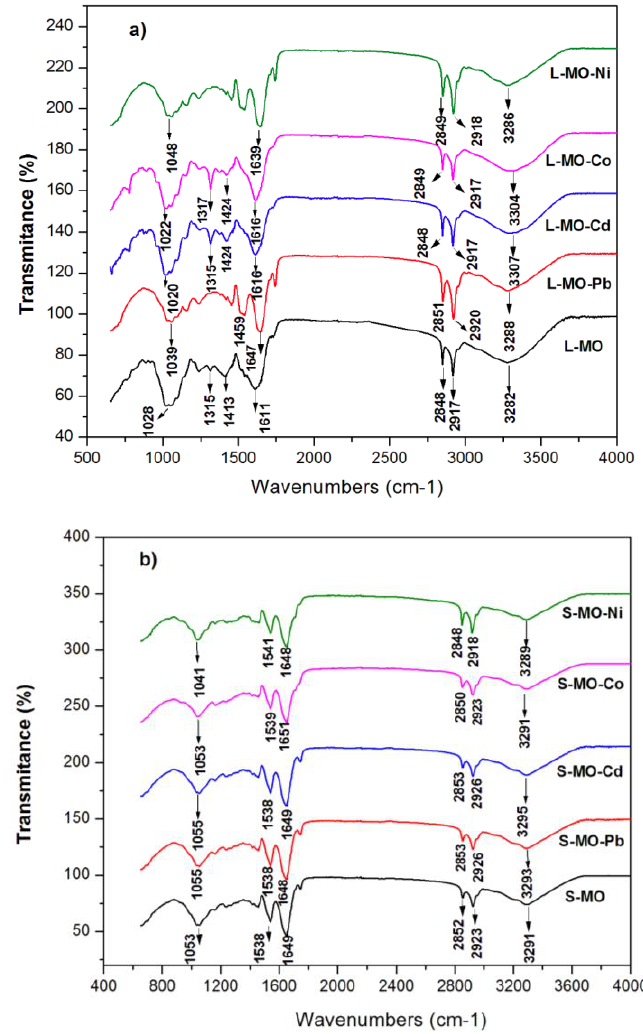
Figure 3. FTIR spectra of ( a ) L-MO, L-MO-Pb, L-MO-Cd, L-MO-Co, and L-MO-Ni; and ( b ) S-MO, S-MO-Pb, S-MO-Cd, S-MO-Co, and S-MO-Ni. Based on XRD and FTIR results, the mechanism of adsorption following Scheme 1 is proposed.